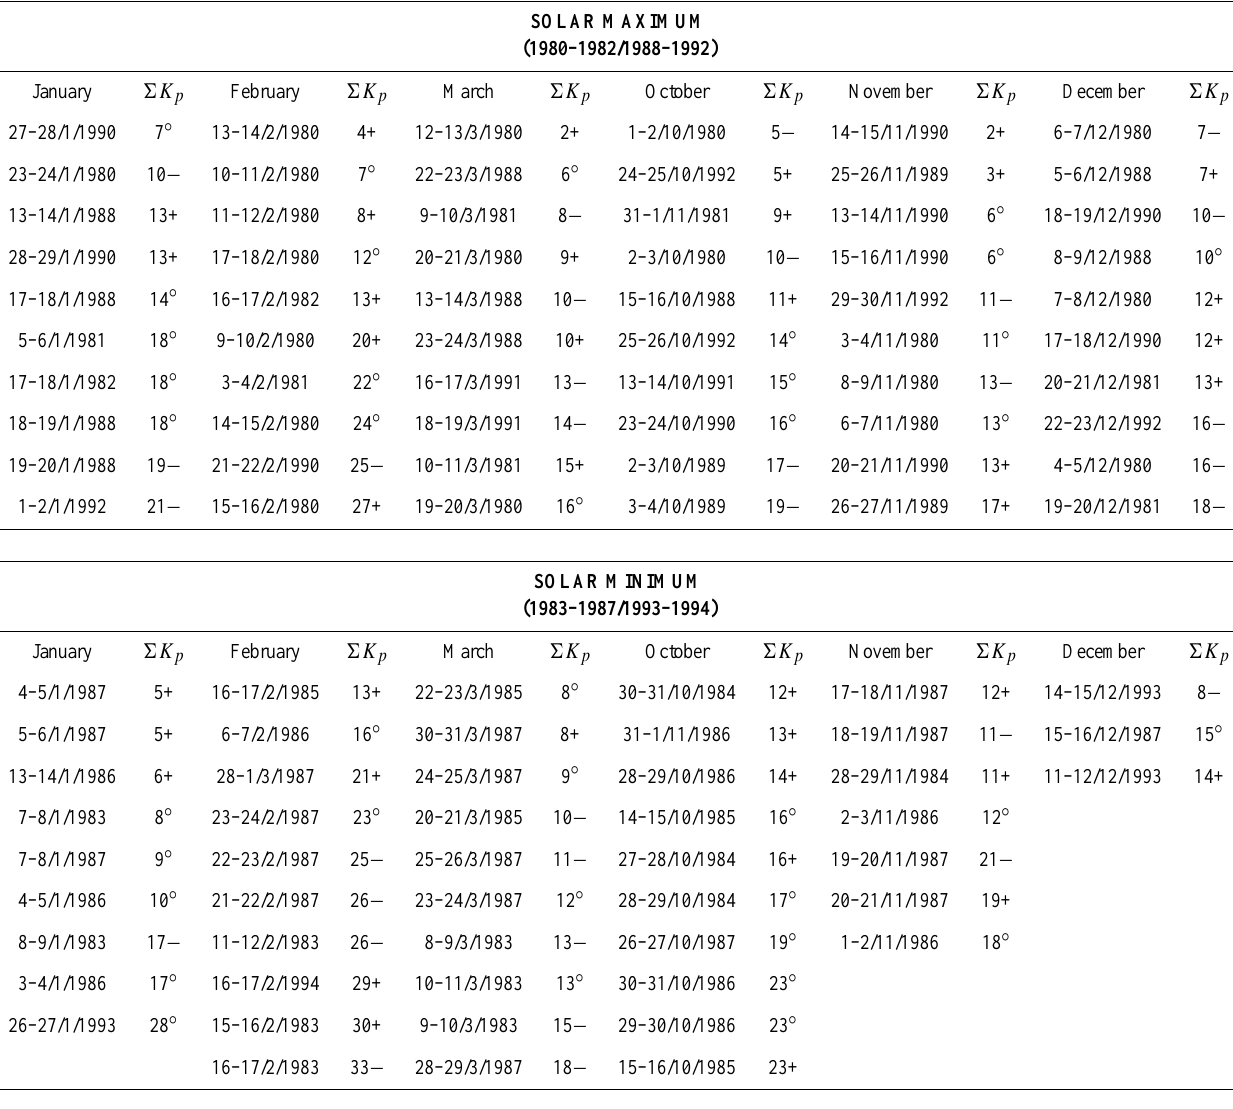
Table 1. Nights with the smallest 6K p during the period of October to March, between 1980–1994, of maximum and minimum solar